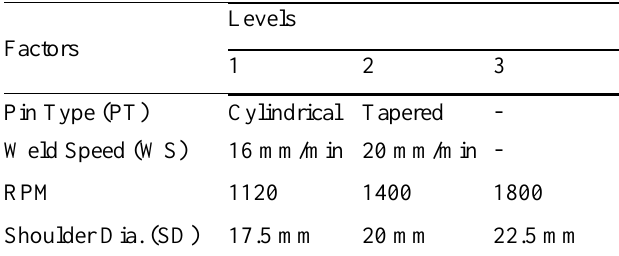
Table 3. Factors with their